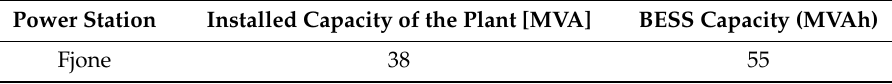
Table 5. Battery installations in the NPS model in the year